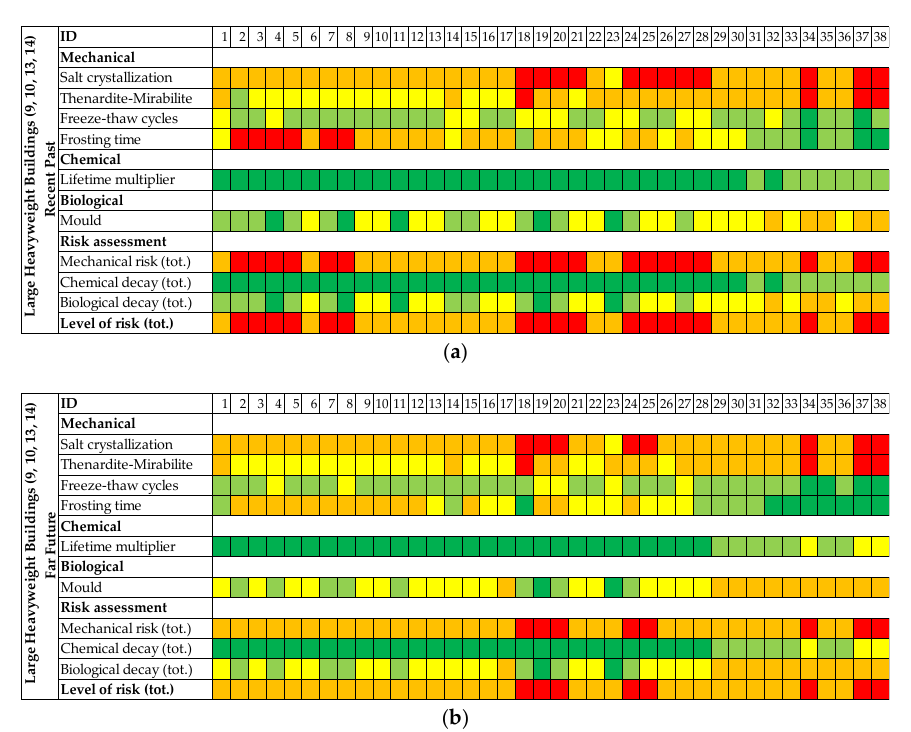
Figure 6. Risk assessment matrix of the deterioration of large heavyweight buildings in: ( a ) Recent Past (1961–1990); ( b ) Far Future (2071–2100).